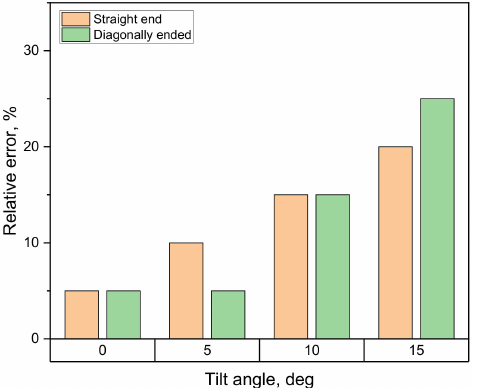
Figure 13. Relative error of piezoelectric sensor indication depending on its tilt angle in simula- tion